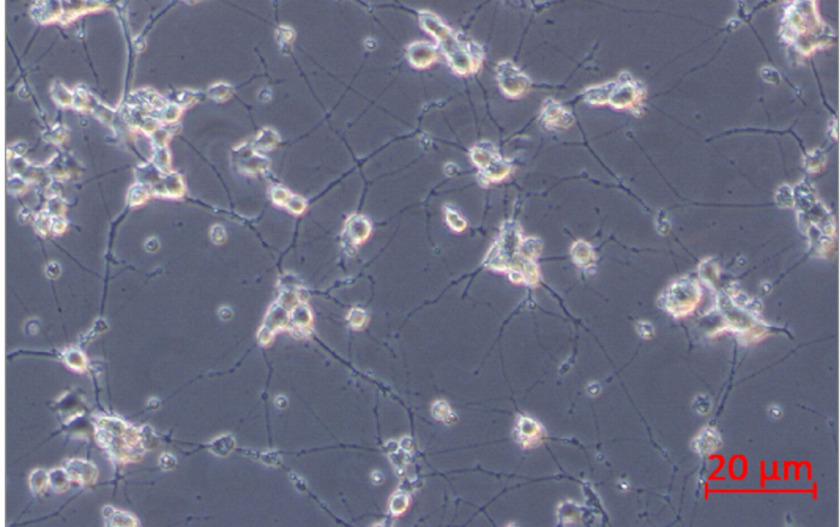
Figure 13. PC12 cells after 10 days of incubation with nerve growth factor